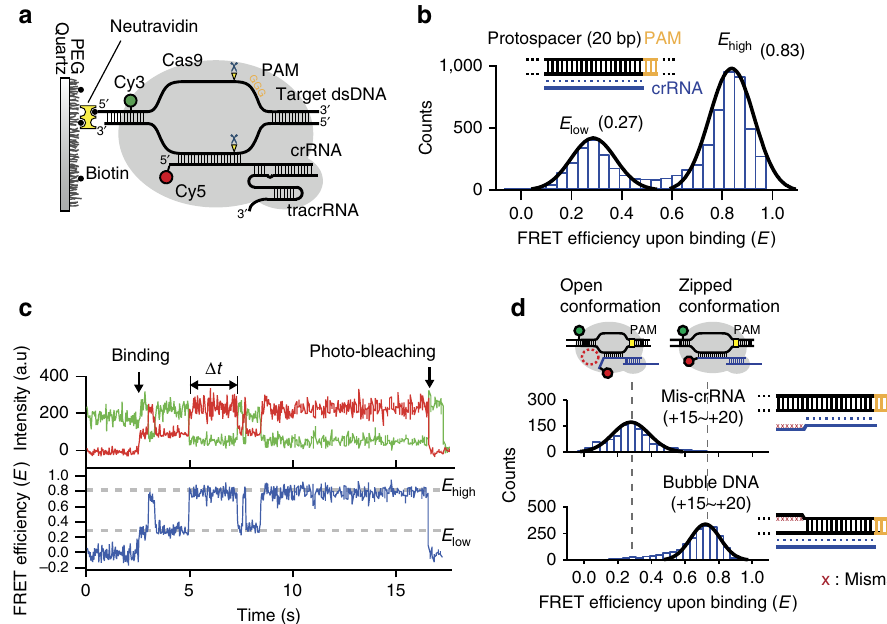
Figure 2 | Single-molecule FRETanalysis for sub-conformation of Cas9:gRNA:DNA. ( a ) Scheme for smFRETexperiment. Cas9 with gRNAs that consist of Cy5 (acceptor)-labelled crRNA, tracrRNA, binds to Cy3 (donor)-labelled dsDNA. In the FRET measurement, a relatively low concentration of gRNAs (30nM) compared with cleavage experiments was used to reduce the background fluorescence of Cy5-labelled crRNA. ( b ) A histogram of the FRETupon binding (we selected the molecules emitting Cy5 signal) to wild-type target DNA exhibits two peaks centred at 0.27 and 0.83, with Gaussian fits (black line). ( c ) A representative time trajectory representing the short-lived open conformation and zipped conformation exhibits two FRET states. The duration of each conformation is measured as the dwell time ( D t ). The trajectory was imaged right after the injection of Cas9:gRNA into a single-molecule chamber with an integration time of 0.03s. The points of binding and photo-bleaching were indicated by the black arrows. ( d ) Histograms of FRET upon binding with each PAM-distal mutant exhibit different conformational distribution (with Gaussian fits, black line). The ‘mis-crRNA’ represents the sequence containing mismatched bases between target and crRNA in PAM-distal region (from þ 15 to þ 20) and the ‘bubble DNA’ represents the sequence containing mismatched bases between nontarget and target strand in PAM-distal region (from þ 15 to þ 20). In b and d , diagrammatic representations are used for PAM (yellow), protospacer (black), crRNA (blue) and the approximate location of mismatched bases on target DNA (red